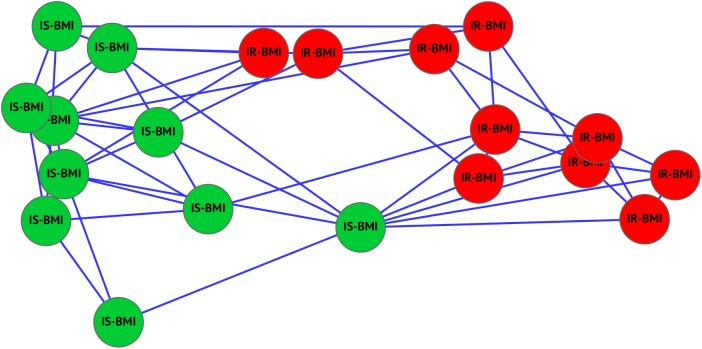
Network of subject groups in the IS-BMI and IR-BMI study of the ASCM pathway.Networks represent subjects’ classification in the validation study of the ASCM pathway in groups with high BMI (IS-BMI and IR-BMI). Nodes represent subjects (green ones are IS-BMI subjects, red ones are IR-BMI). The edge length is proportional to the difference between the subject signatures (short edges indicate high similarities, long edges indicate low similarities, no edge indicates a negligible similarity). In each case subjects naturally cluster together according to the class they belong to. See also S3 Table.